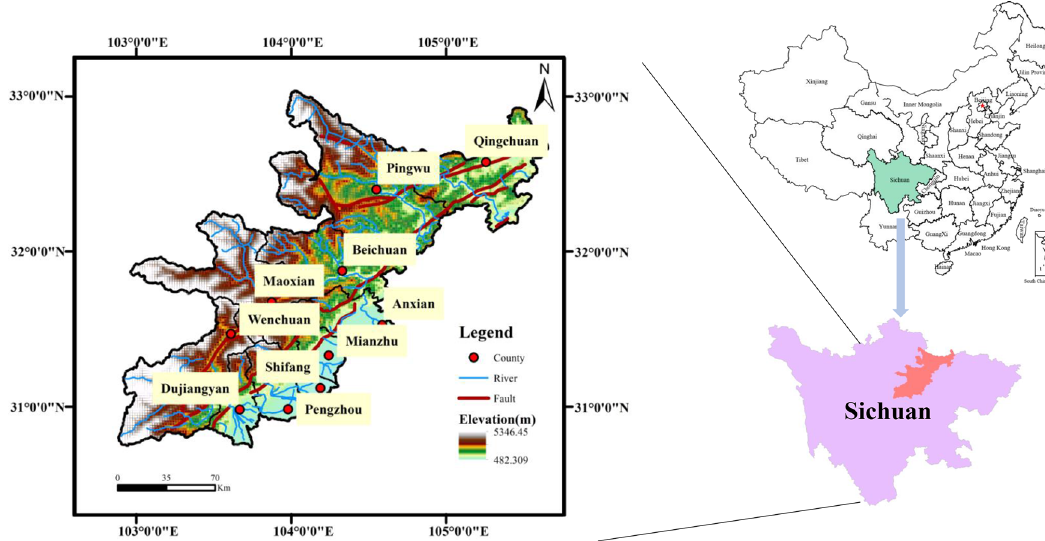
Figure 2. Map of the study area (Names of software: ArcGIS 10.5 and Office